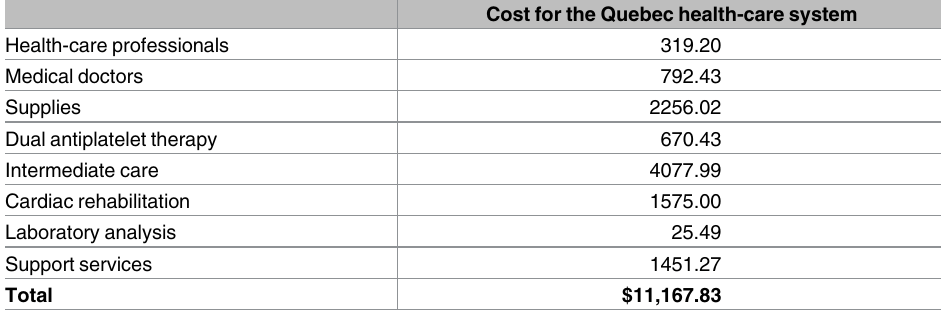
Table 6. Cost of reintervention following a revascularization failure in